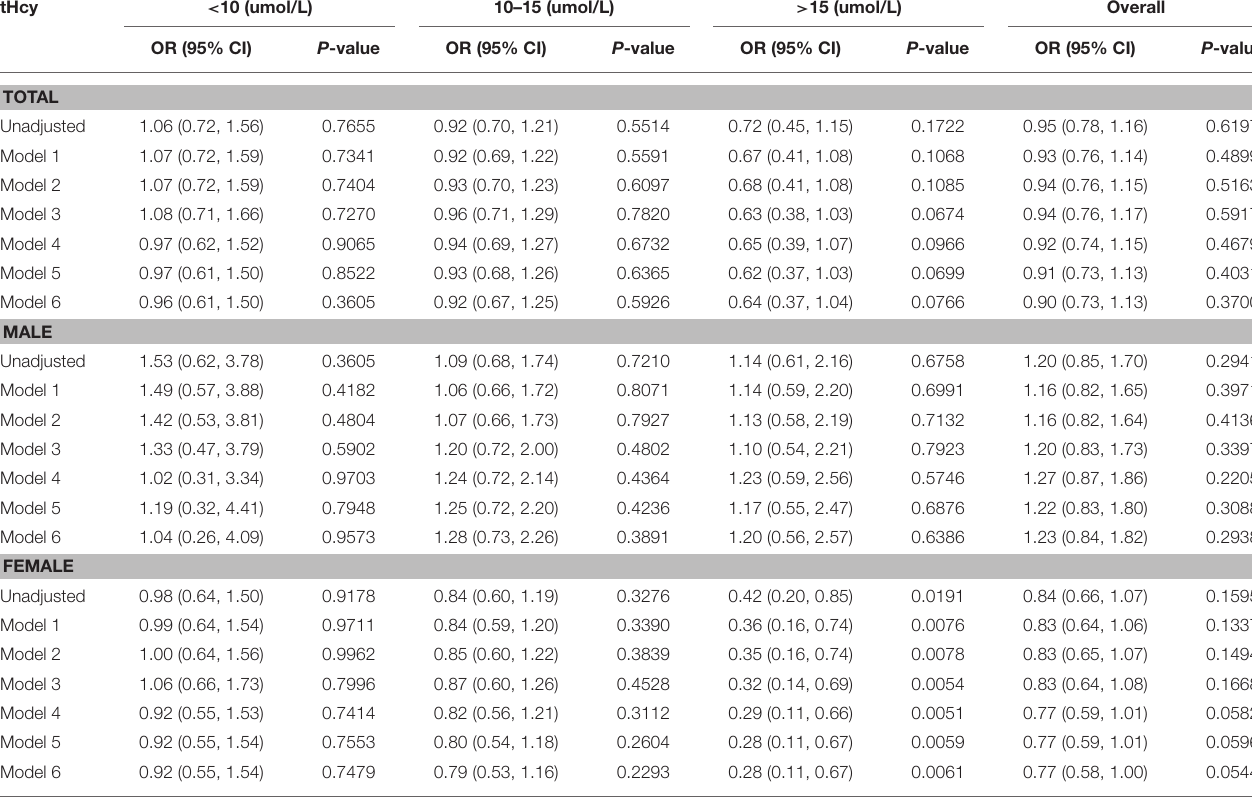
TABLE 4 | Associations of folic acid intake with retinal